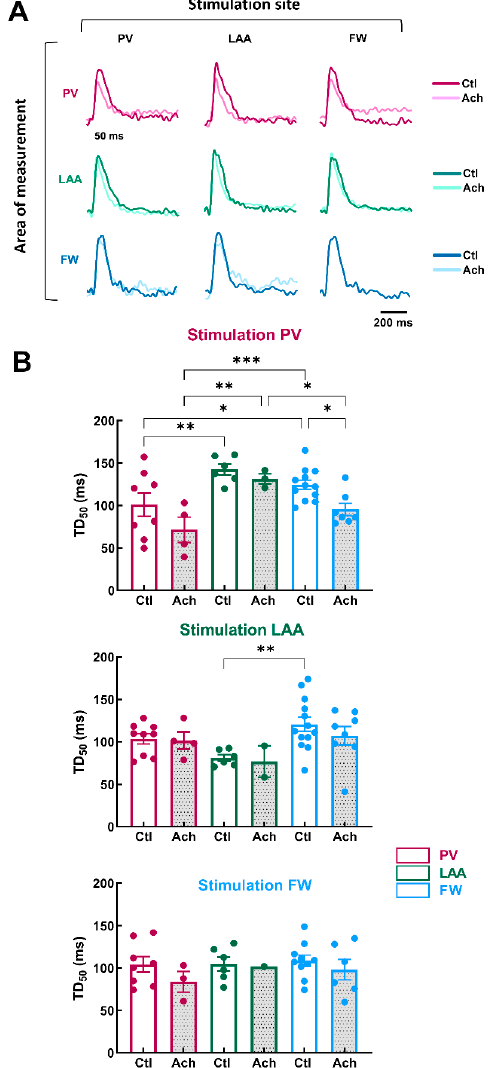
Figure 5. Calcium transient in three regions of LA by pacing at three different stimulation sites. ( A ) Representative optical calcium transient under control perfusion (Ctl) or immediately after administration of acetylcholine (Ach 10 μ M) measured in three regions (area of measurements, PV, LAA, FW, top to bottom) at three different pacing sites (PV, LAA, FW, left to right). ( B ) Mean data for calcium transient decay time to 50% (TD 50 ) at three pacing sites (PV, LAA, FW, top to bottom) measured in three regions PV (purple), LAA (green), FW (blue) under control perfusion (Ctl, open bar) or after administration of acetylcholine (Ach, grey bar). N = 13; One-way ANOVA followed by a Tukey’s multiple comparison test * p < 0.05, ** p < 0.01, *** p < 0.001.